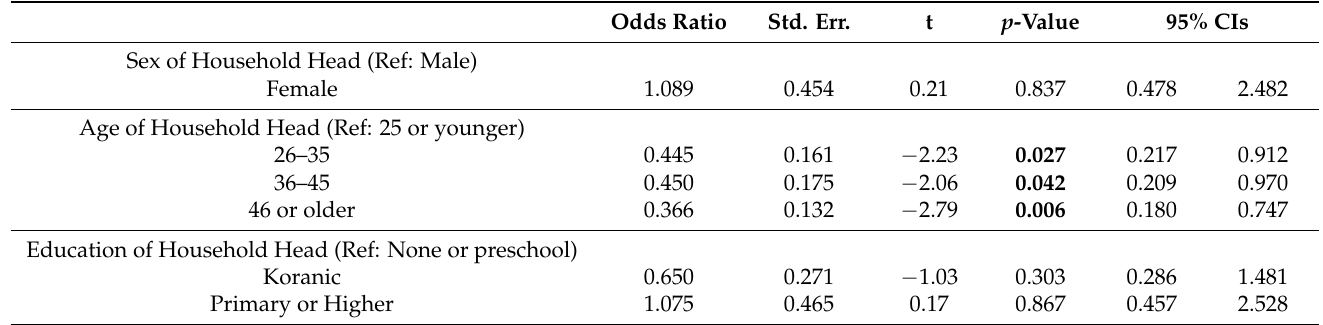
Table 4. Results of multiple logistic regression on mosquito net use in the previous night